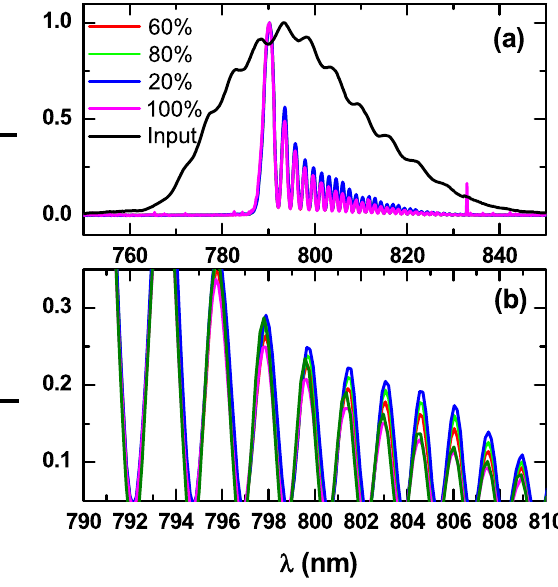
FIG. 9. (Color) (a) Variation of measured spectra as functions of AOPDF settings and (b) the detail of (a) from 790–810 nm. The target spectrum is the same as in Fig. 8(b), with power level of AOPDF adjusted as noted in the figure. The dark green curve is the target spectrum.